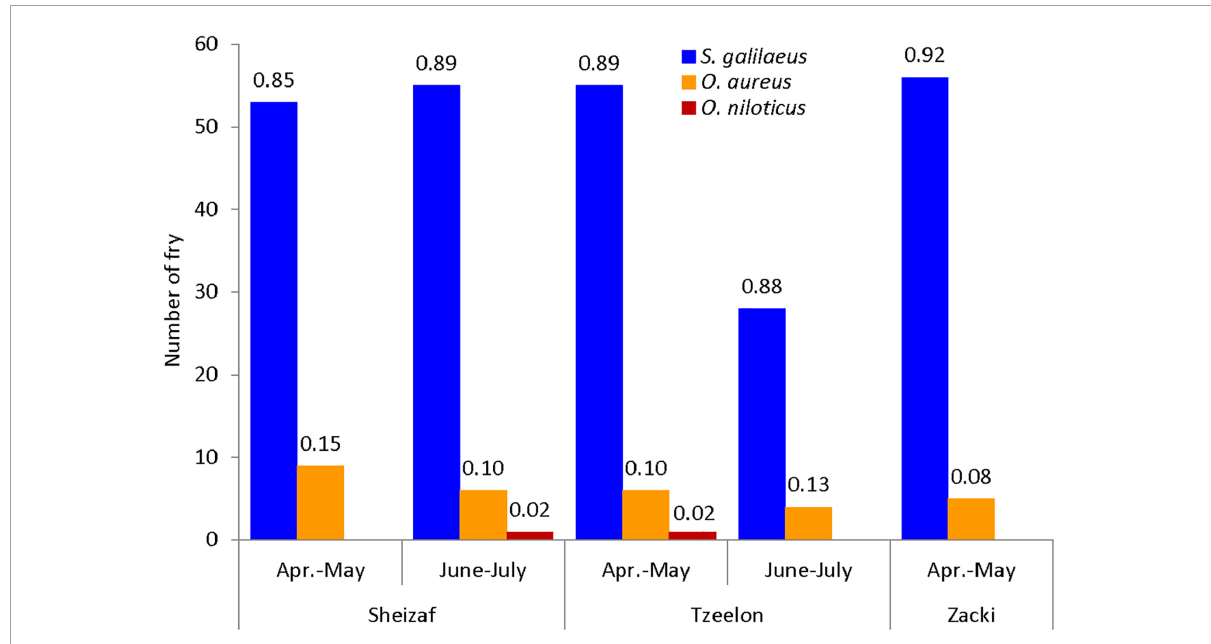
FIGURE4 Distribution of fry by place, period and species as it was identified by the Bar-HRM method. Species are colored differently. On the Y-axis is the number of fry and on column tips, the proportion of each species in its place and period